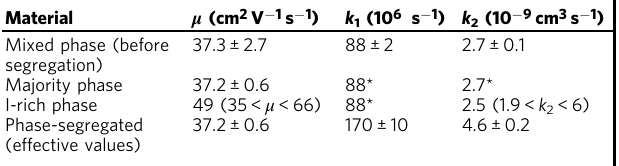
Table 1 Recombination rate